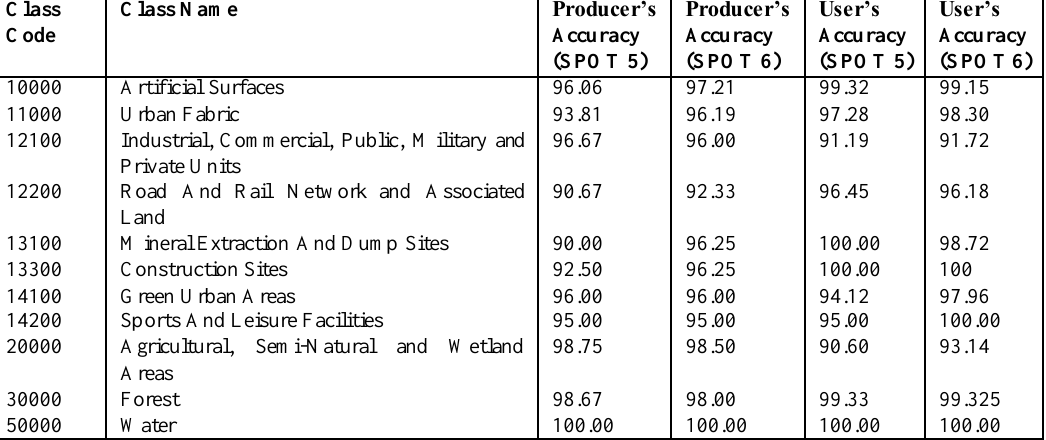
Table 4. Results of the accuracy assessment for each class